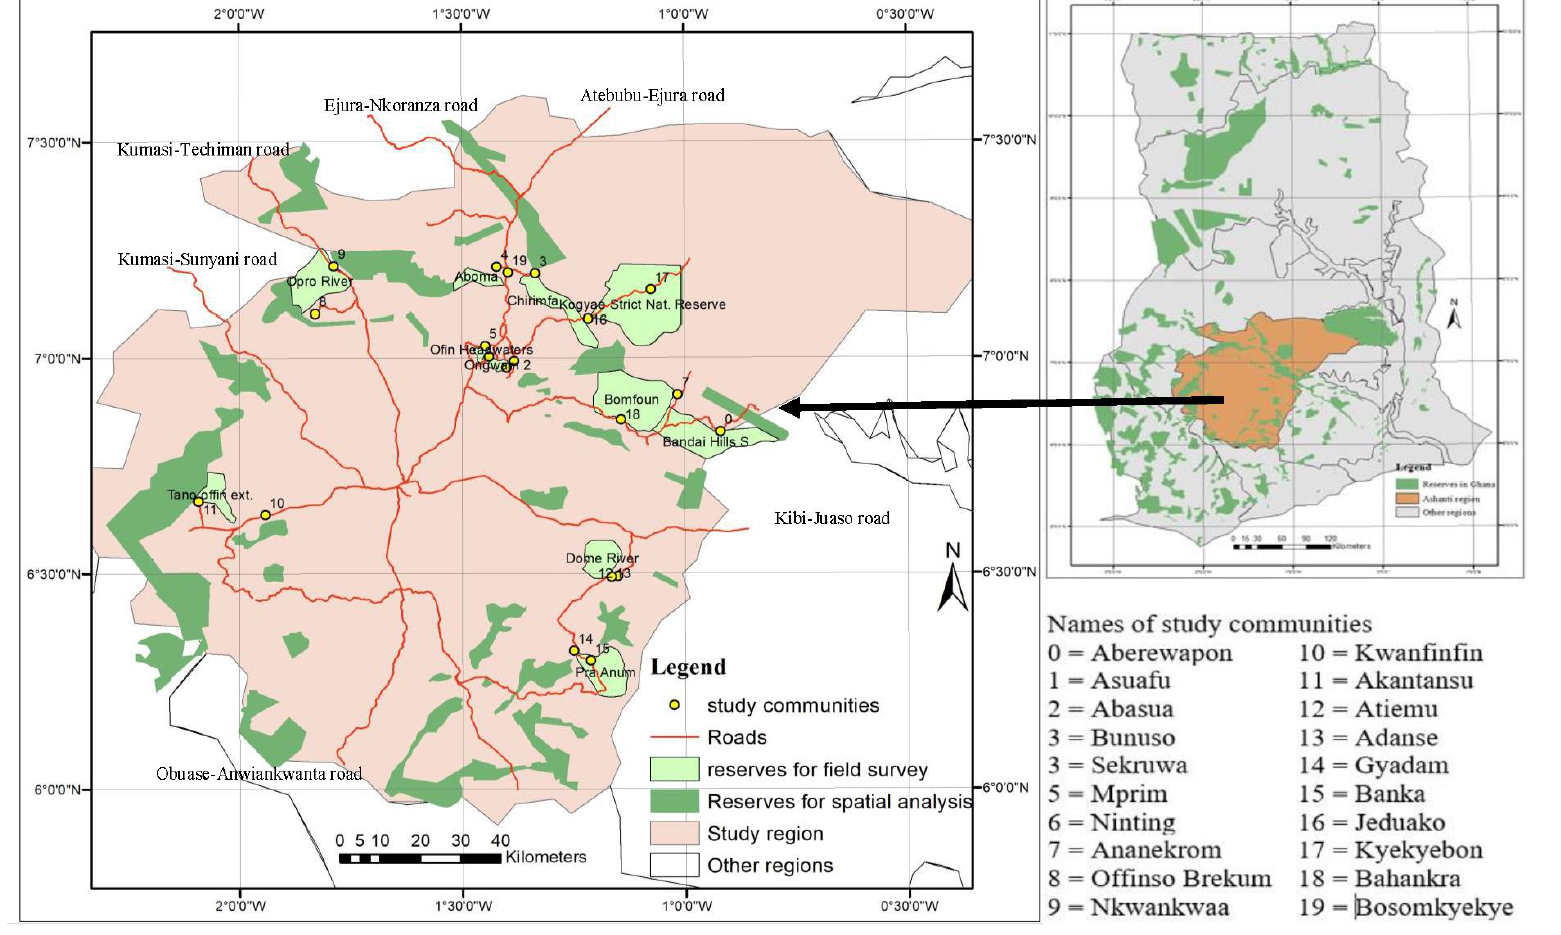
Figure 1. The Ashanti region of Ghana and its forest reserves. Source: [2].